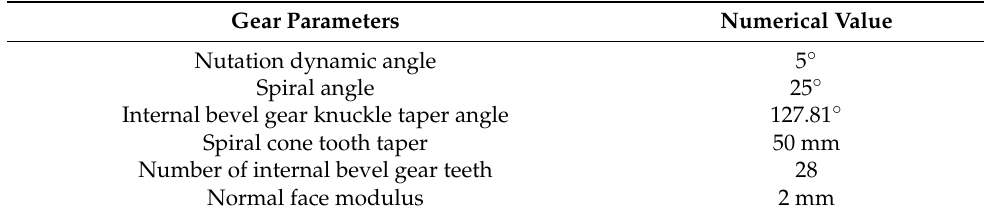
Table 2. Parameters of the spiral bevel